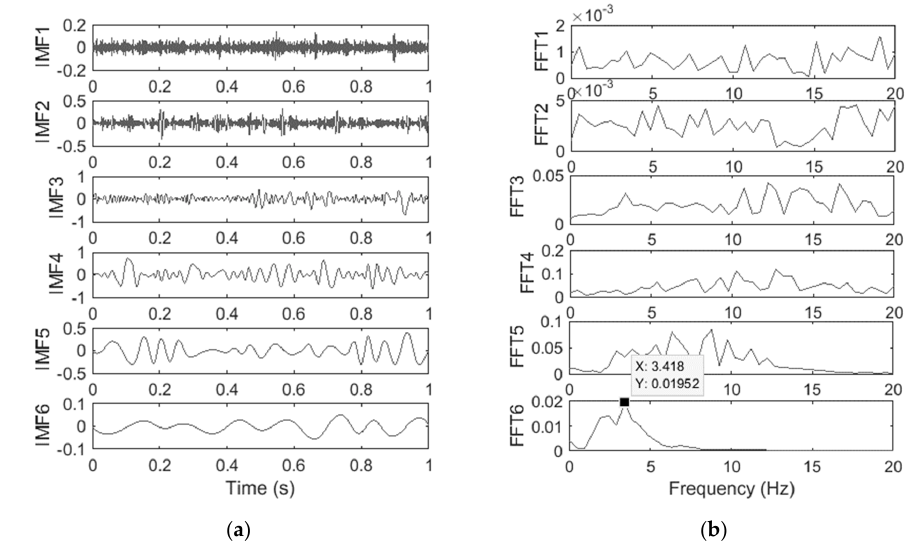
Figure 7. ( a ) IMFs of the vehicle acceleration response and ( b ) FFT of the IMFs of the vehicle acceleration response in the presence of 5% noise.